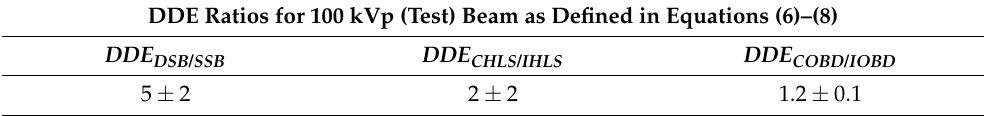
Table 5. The DNA damaging effectiveness (DDE) of the 100 kVp versus 6 MV X-ray beam. DDE Ratios for 100 kVp (Test) Beam as Defined in Equations